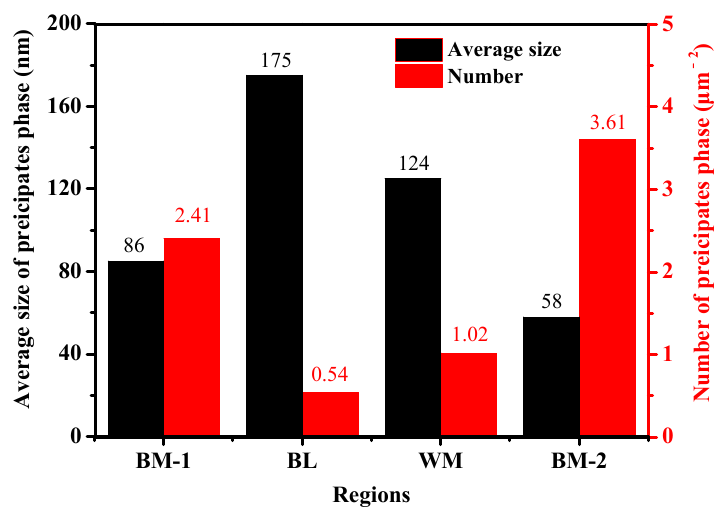
Figure 14. Average size and number of precipitated phases in different regions of the DMWJ.